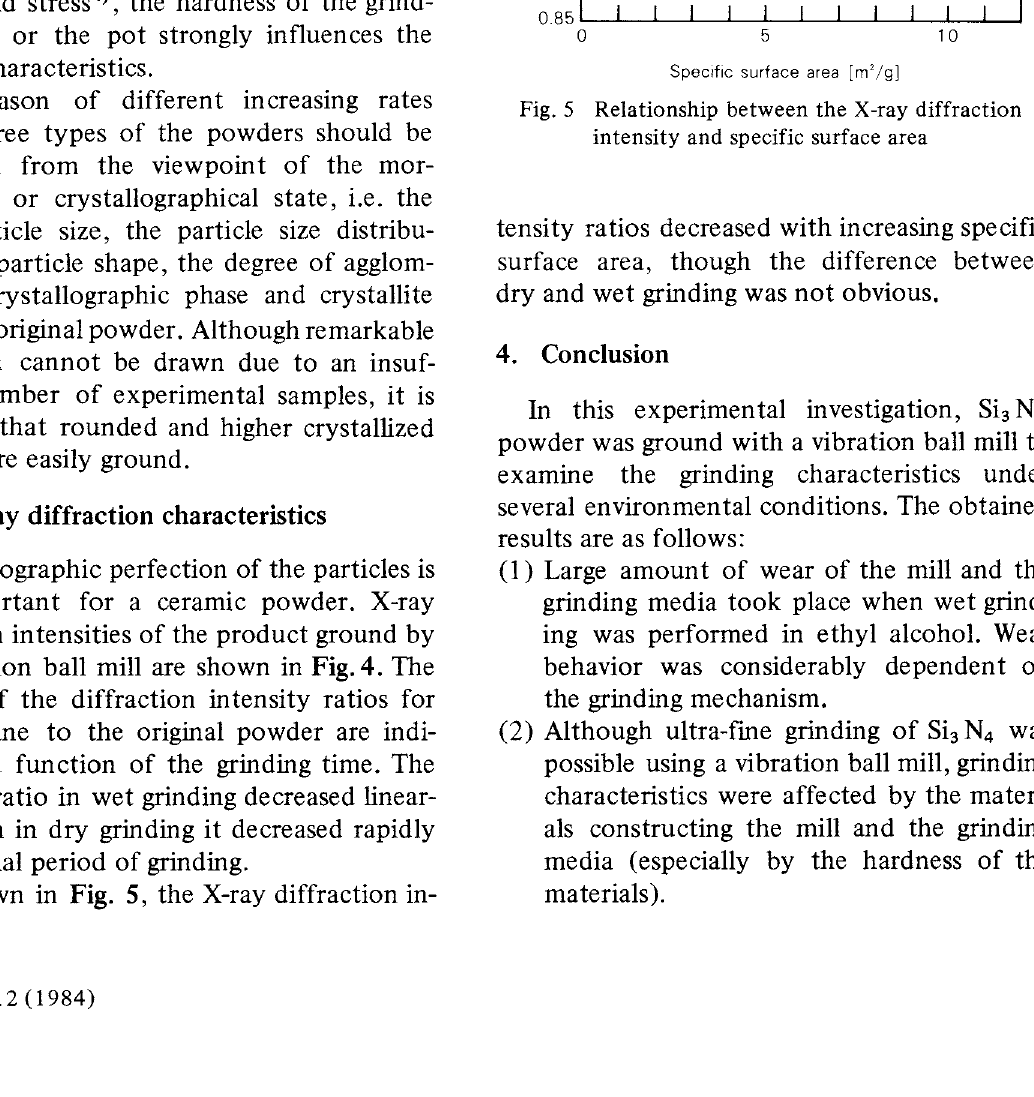
Fig. 4 Decrease of X-ray diffraction intensity as function of grinding time